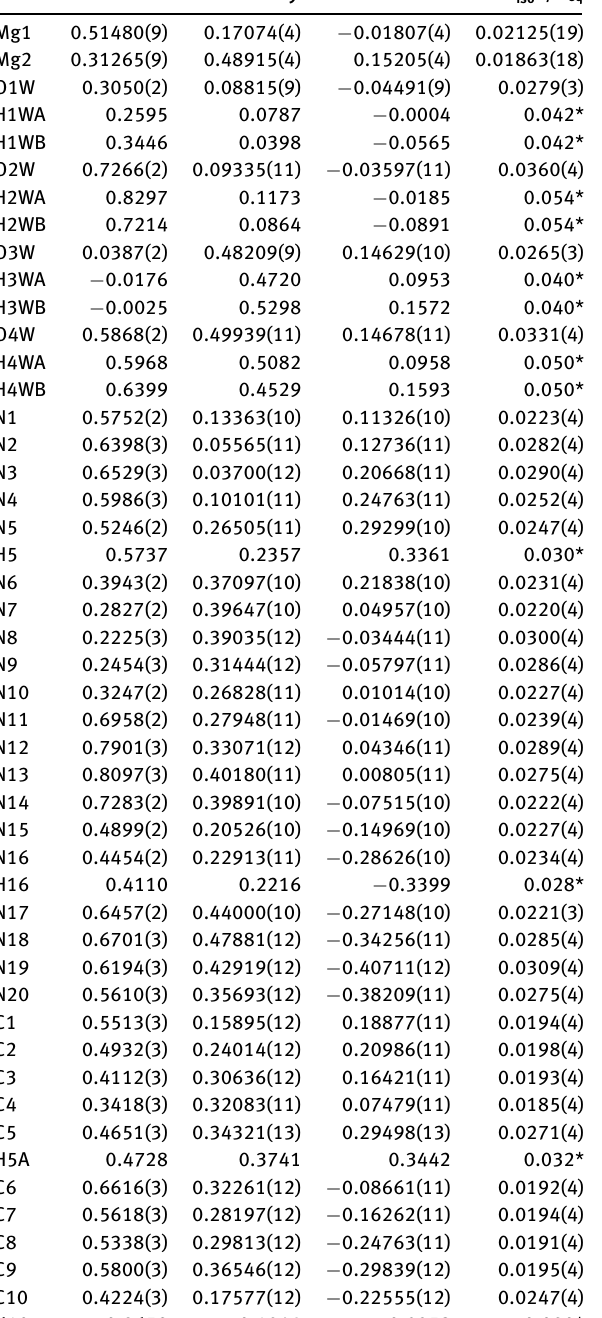
Table 2: Fractional atomic coordinates and isotropic or equivalent isotropic displacement parameters (Å 2